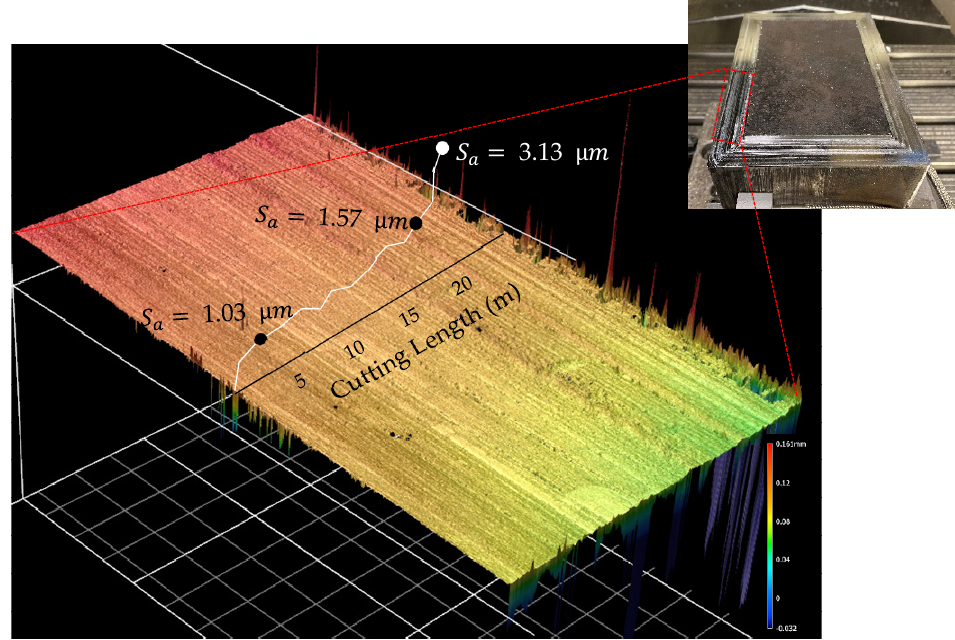
Figure 6. Image and surface map of a steel block; areal surface roughness parameter ( S a ) as a function of cutting length.